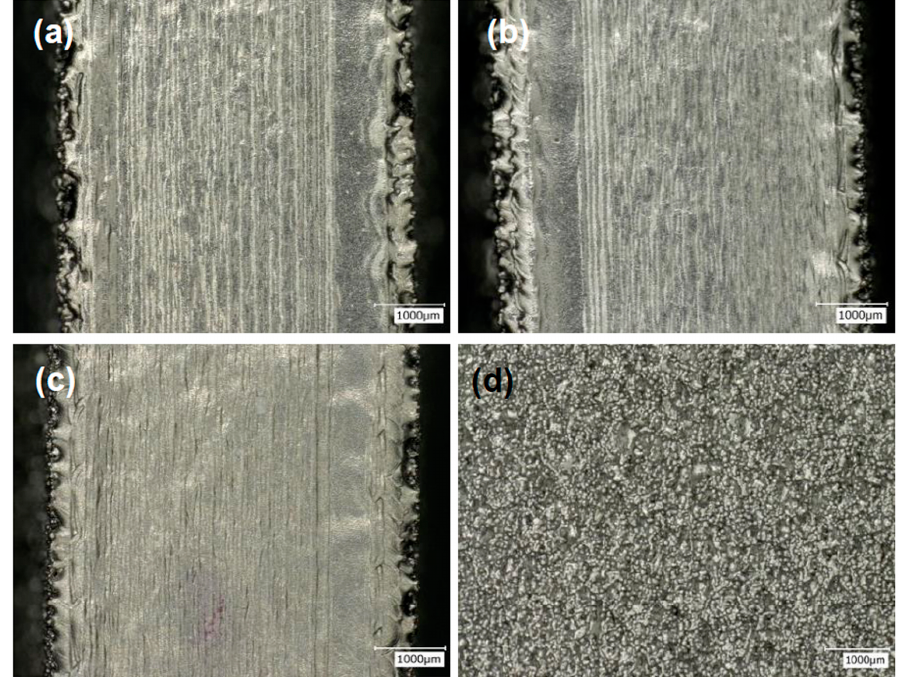
Figure 4. Optical microscopy images showing the surface morphology of ( a ) M3; ( b ) M9; ( c ) M14 from the top view; and the surface conditions of ( d ) M10 from the side